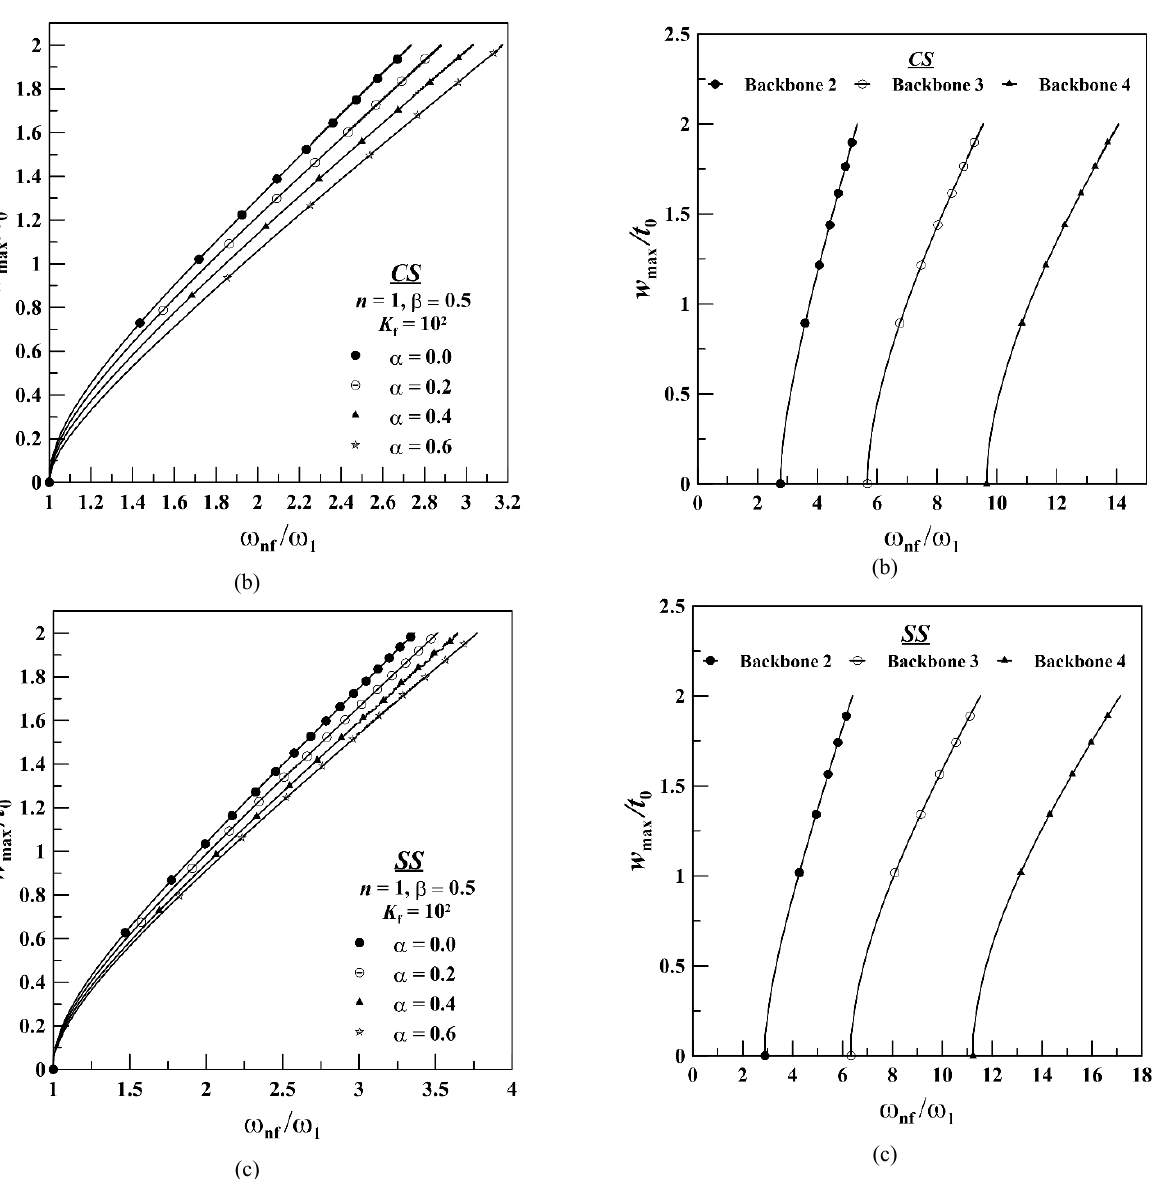
Figure 6. Higher order backbone curve of (a) CC beam, (b) CS beam, (c) SS